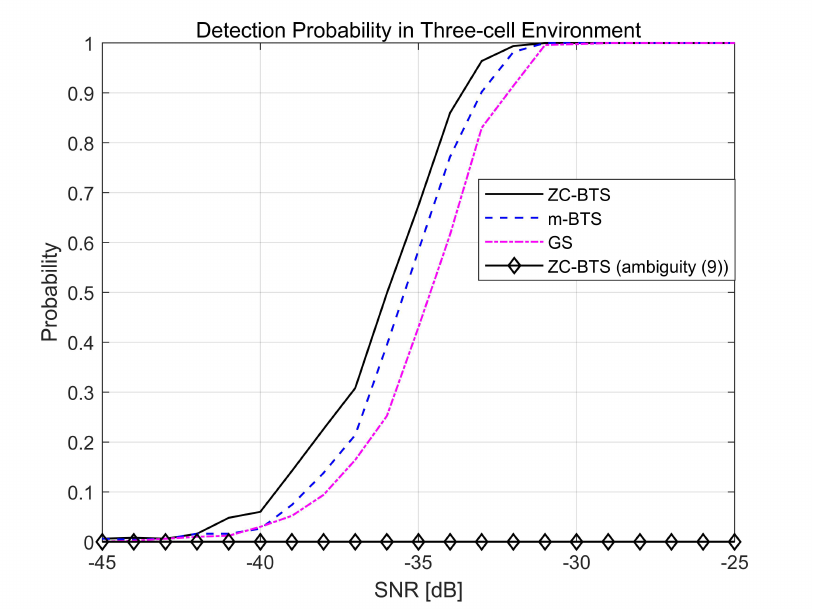
Figure 5. Detection probability for three